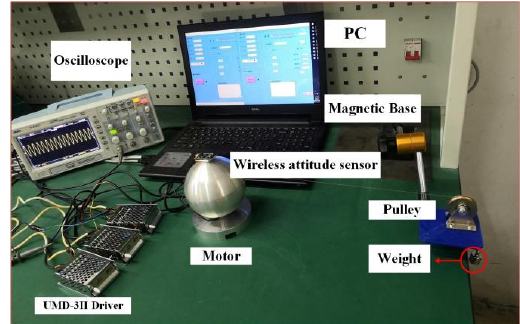
Figure 17. Torque test platform.